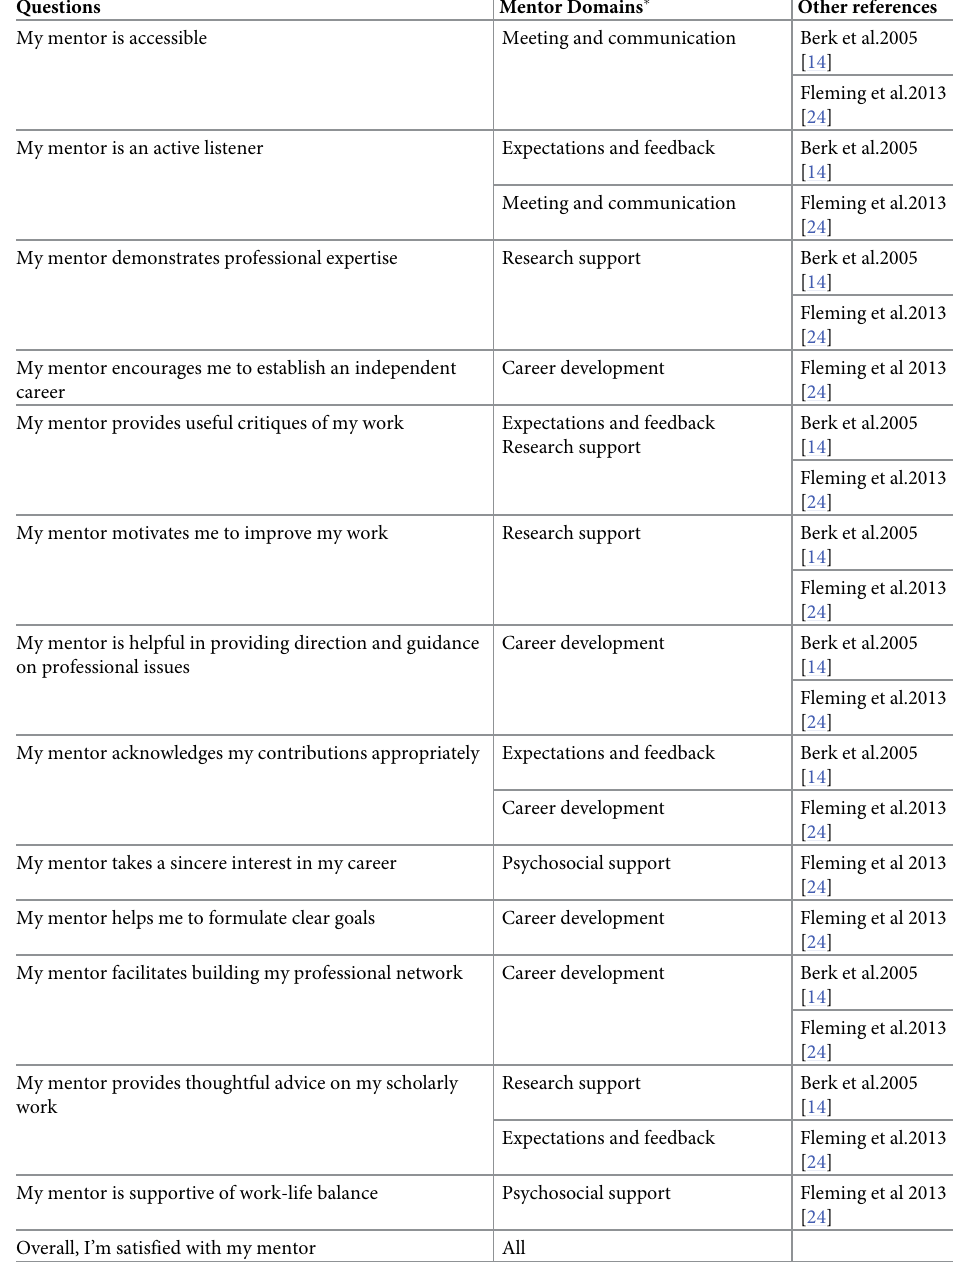
Table 1. Content evidence for the 13-item Mentor Evaluation